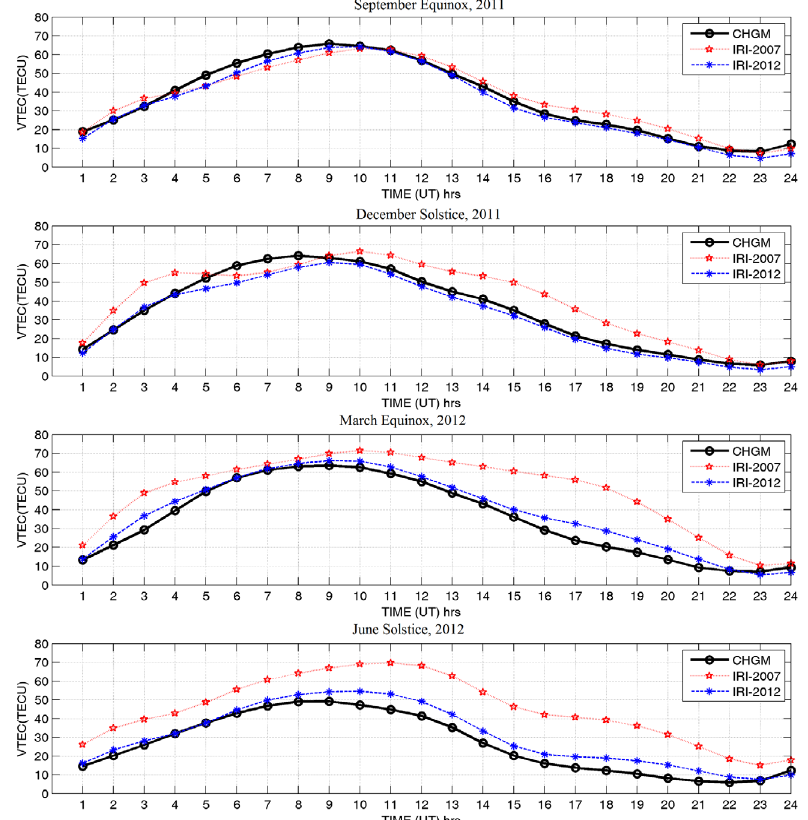
Figure 5. Seasonal mean values of GPS TEC, IRI-2007 TEC and IRI-2012 TEC at CHGM station for the period August 2011 - July